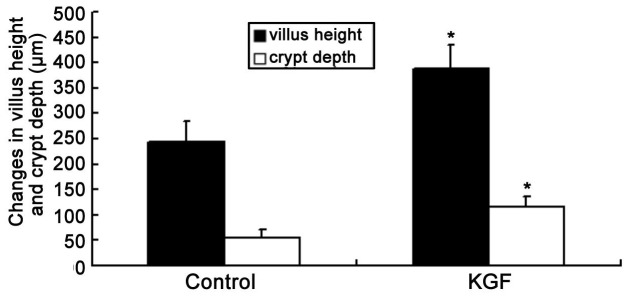
Alterations in villus height and crypt depth in mice after KGF treatment.* P<0.05 vs. control group, n = 6 per group.